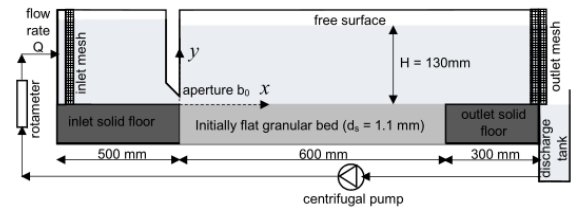
Figure 1: Experience setup by Martino et al. (2019).